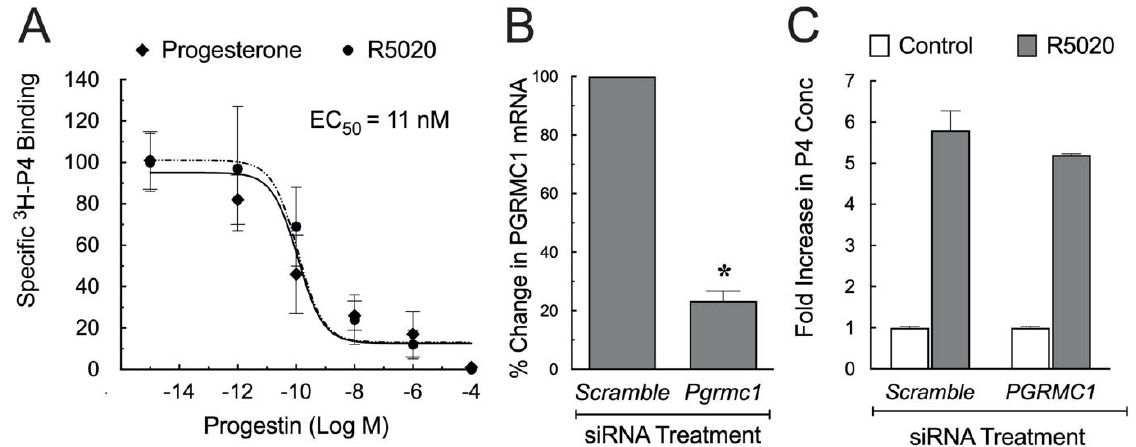
Figure 2. P4 binding characteristic of partially purified human PGRMC1. hGL5 cells were transfected with either an empty vector that encoded GFP or a vector that encoded a GFP-human PGRMC1 fusion protein. Ligand binding studies revealed that both P4 and R5020 displaced 3 H-progesterone with the same dose-dependent characteristics. Curve fitting the binding data revealed an EC 50 of 11 nM for both P4 and R5020 ( A ). Panel ( B ) shows the effect of siRNA treatment on the levels of PGRMC1 mRNA; * indicates a significant decrease from scramble siRNA ( p < 0.05). The effect of R5020 on P4 secretion after 3 days of treatment with either scramble or PGRMC1 siRNA is shown in Panel ( C ). Data taken from Peluso et al. [62].